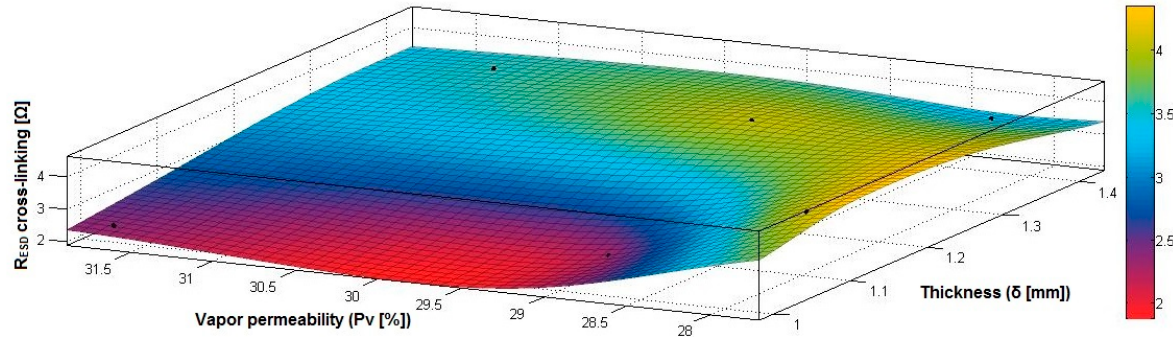
Figure 39. 3D representation R ESD after crosslinking = f(Pa, δ ) samples preliminarily treated in RF plasma O 2 using RF 2 generator and power 50 W.